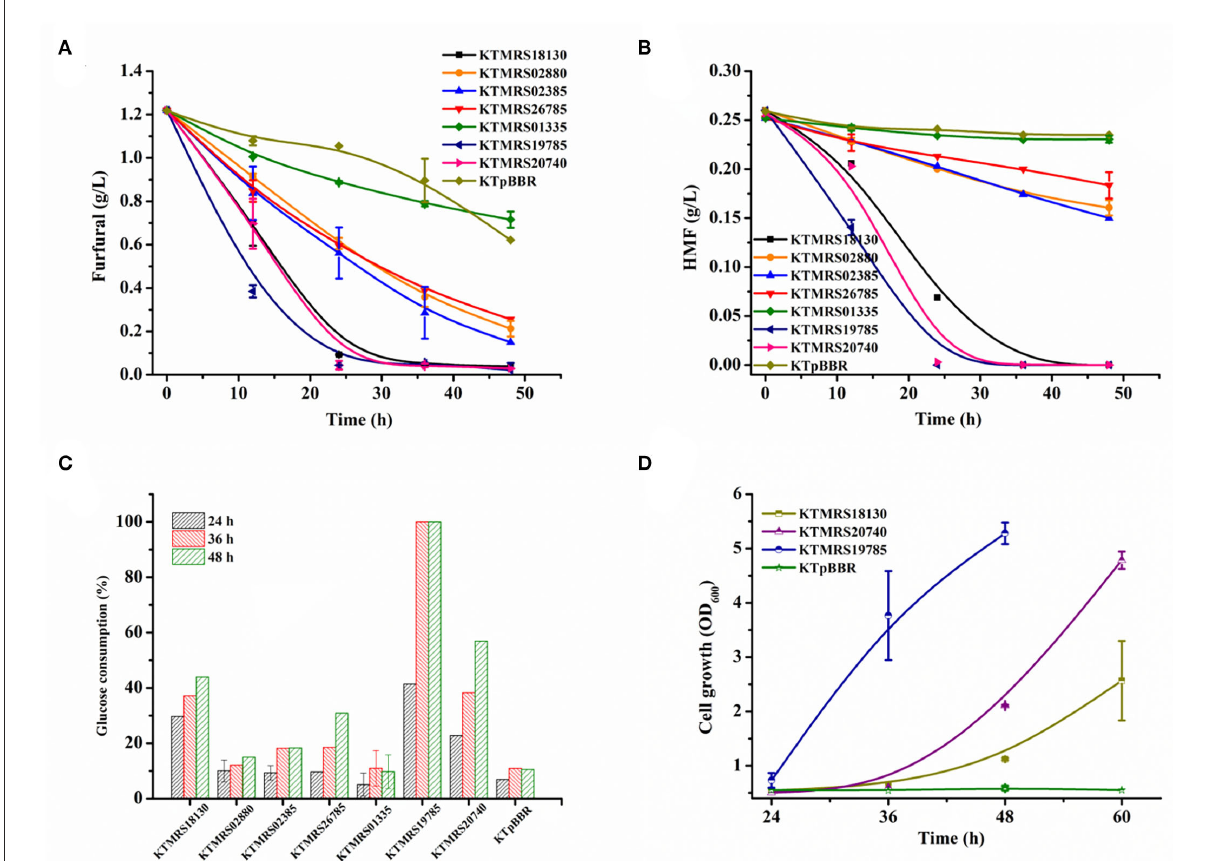
FIGURE6 Performance evaluation of recombinant strains in real hydrolysate. The conversion of furfural (A) and HMF (B) of recombinant strains; glucose consumption profiles (C) of recombinants and the growth of representative recombinants (D) during the period of furfural and HMF conversion; the verification was conducted in corn stover hydrolysate medium. All data are the mean value ± standard deviation of independent duplicate.